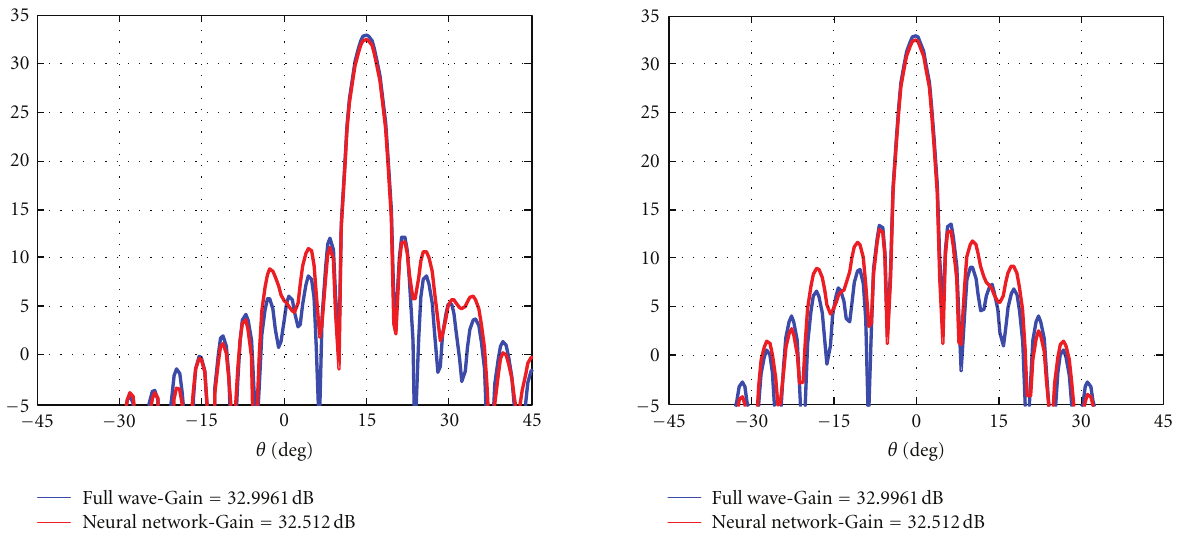
Figure 9: Radiation pattern of the RA antenna with modified Malta Cross reradiating elements at 7.8GHz: comparison between the results obtained using full-wave computed reflection coe ffi cient values or ANN.